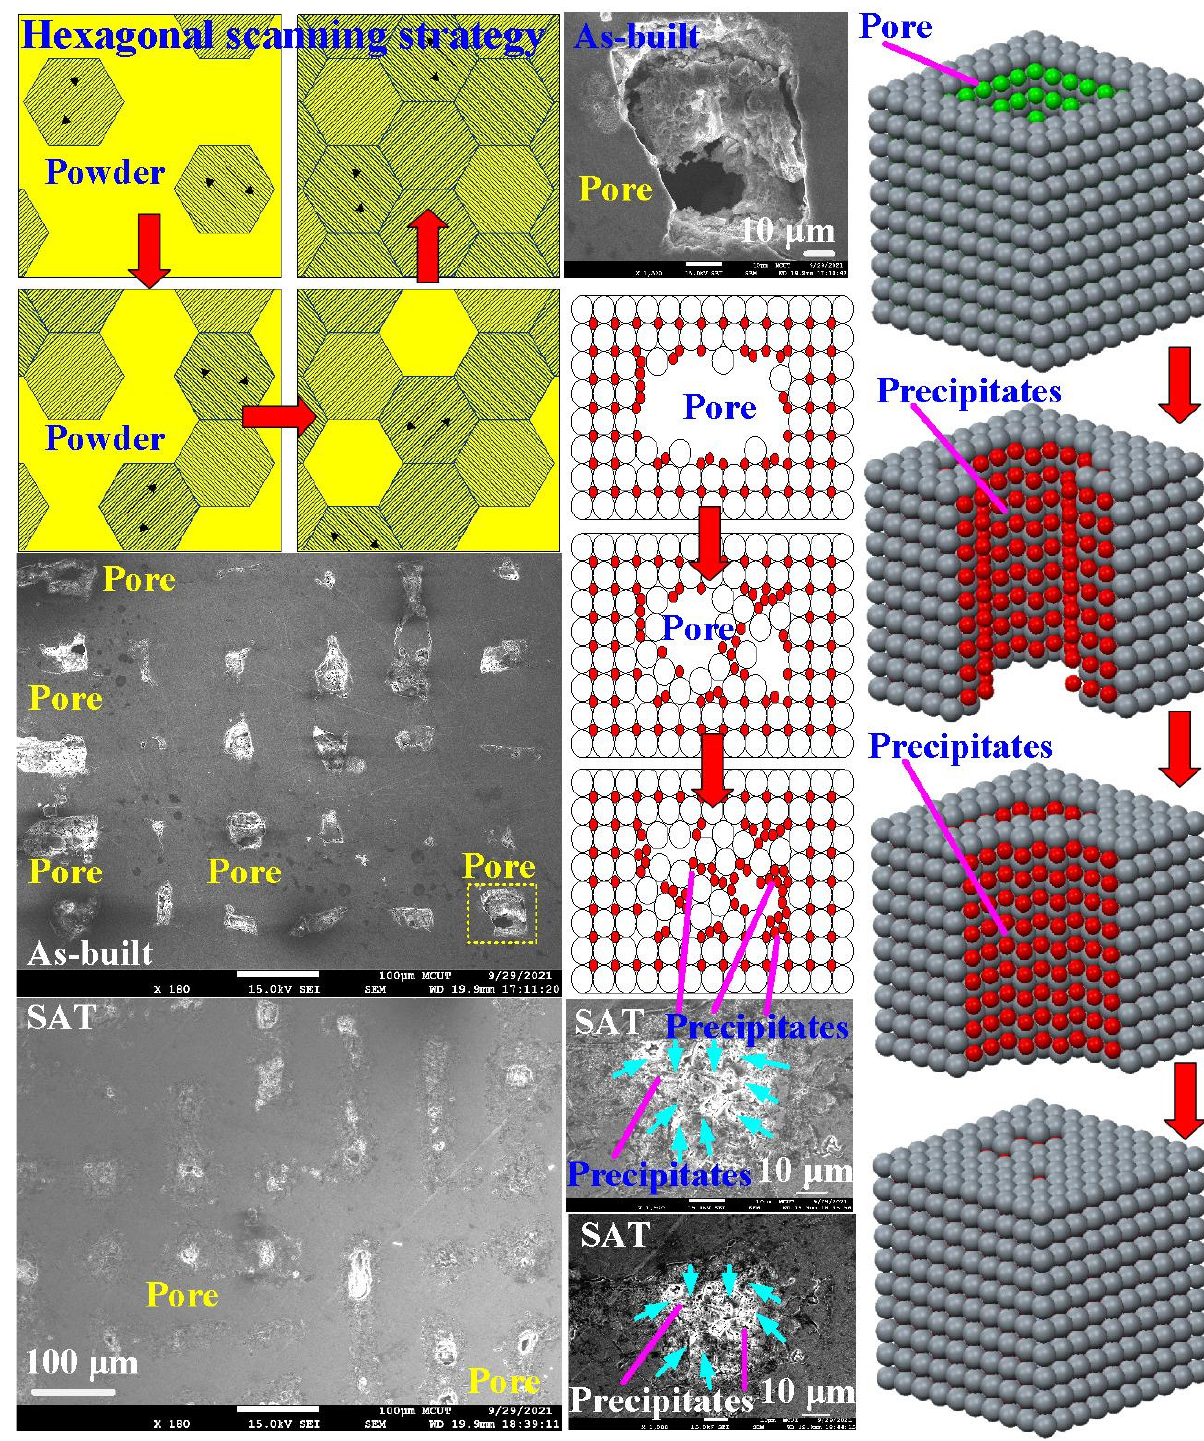
Figure 10. Microstructural evolution of the injection mold after SAT with the optimized procedure.